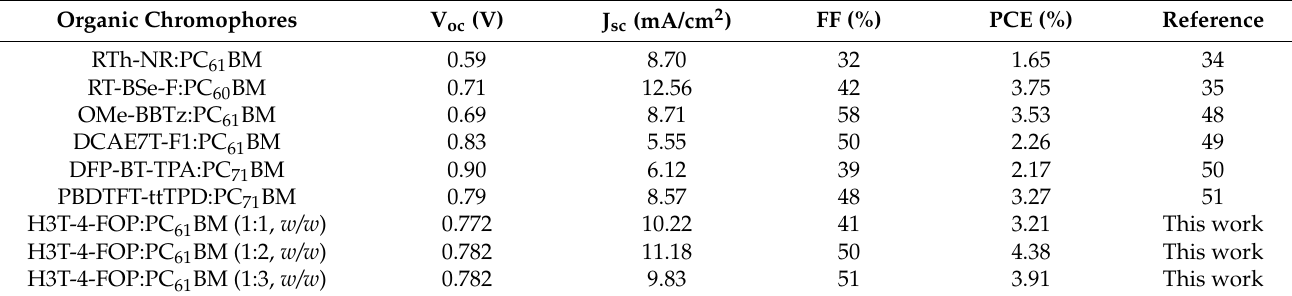
Table 3. Comparative study of fabricated BHJ-OSCs with different organic chromophores and H3T-4-FOP.